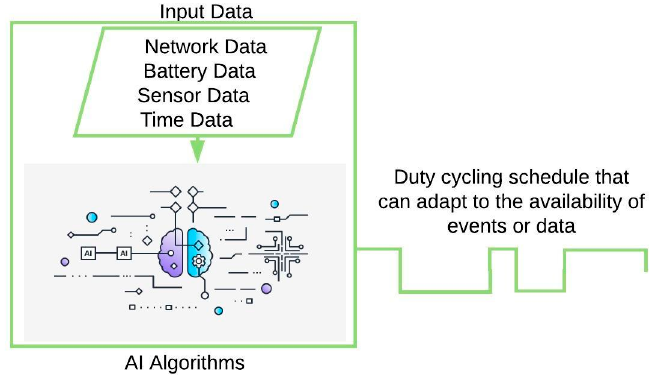
Figure 6. Some input data and their potential usage with AI algorithms .